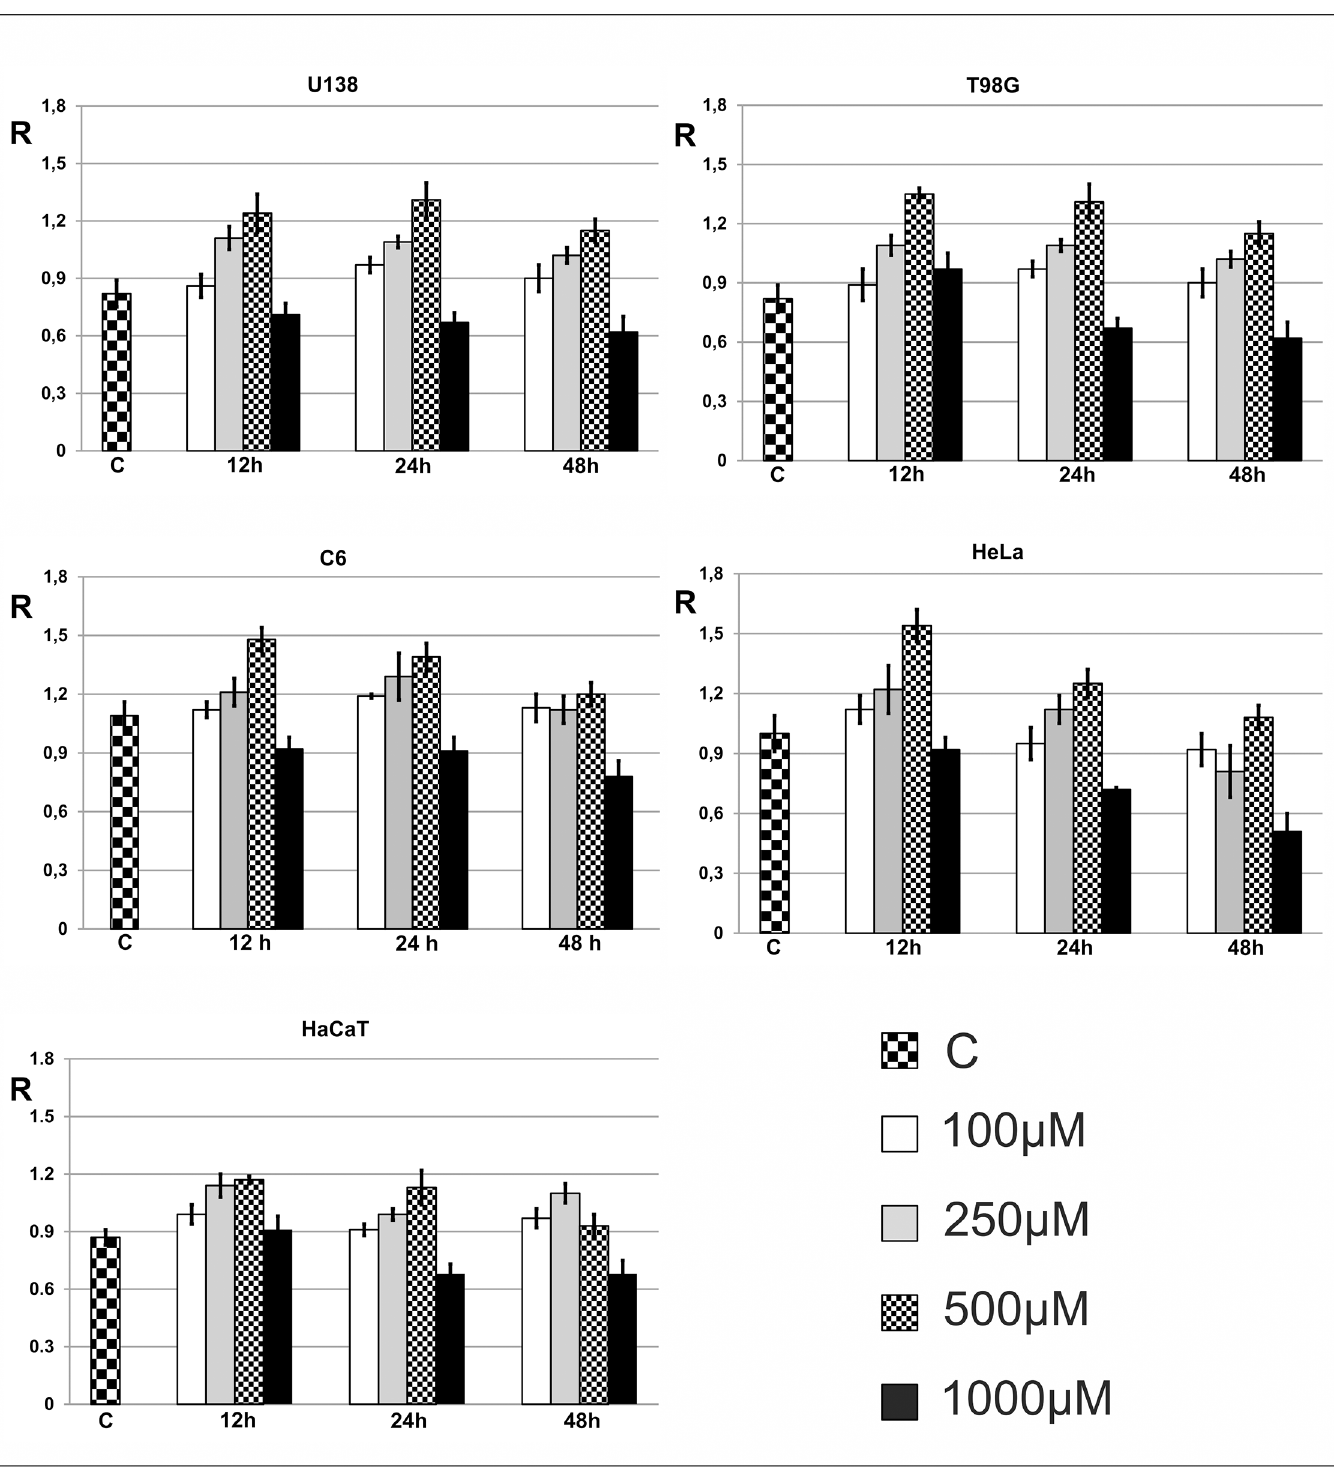
Fig 4. The effect of TMZ on 5 methylcytosine (m 5 C) contents in DNA of glioma. (U138, T98G, C6) and HeLa cells at 3, 12, 24 and 48 h. HaCaT cell line was used as the reference. C stands for control cells treated with DMSO only.